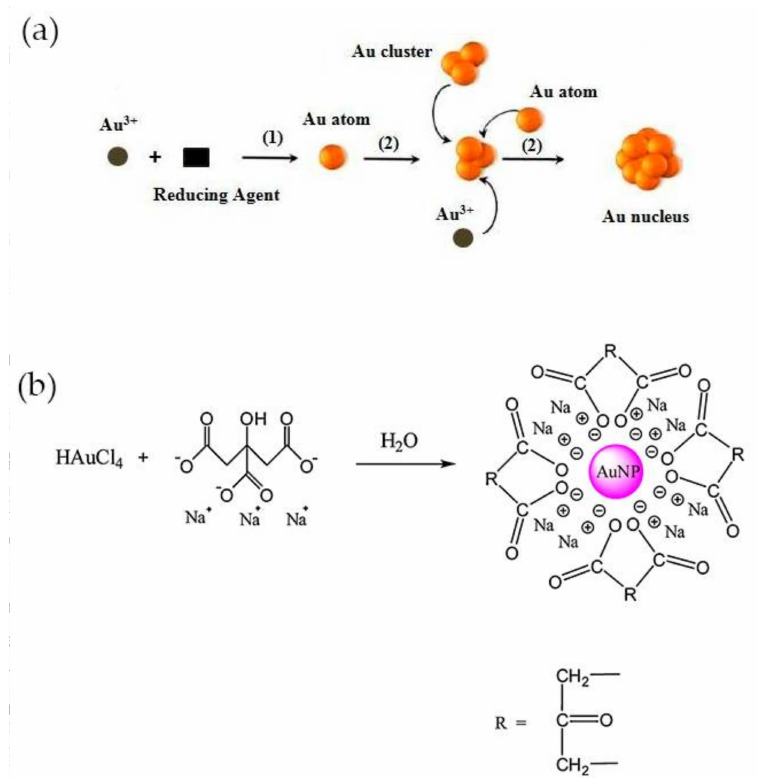
Figure 2. ( a ) Process of nucleation for synthesis of Au NPs by chemical reduction method. Reproduced with permission from ref. [35]. Copyright Elsevier Ldt, 2010; ( b ) Representation of Turkevich method. Reproduced with permission from ref. [33]. Copyright Elsevier B. V.,